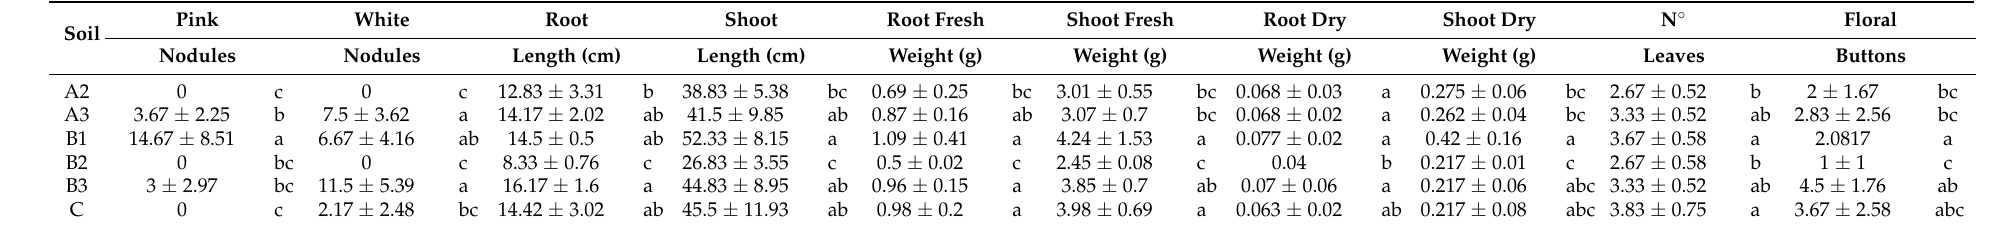
Table 2. Growth parameters of red kidney beans used as a trap